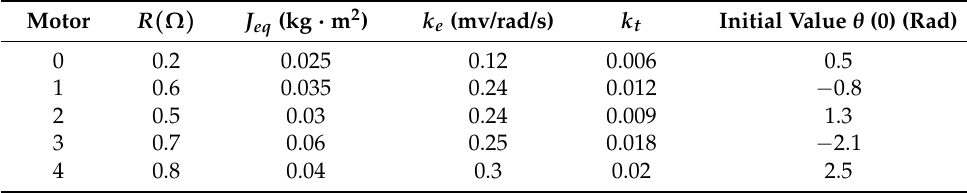
Table 1. Parameter settings of all